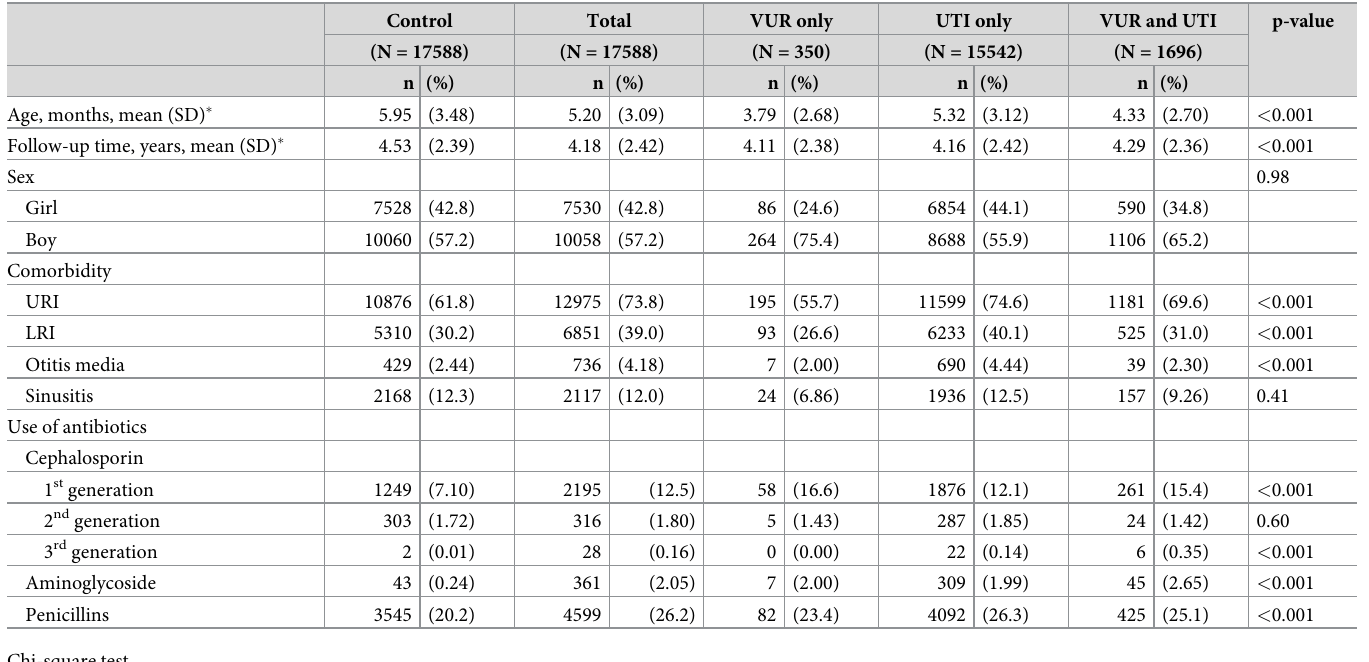
Table 1. Demographics among the 4 cohorts: Vesicoureteral reflux (VUR) cohort, urinary tract infection (UTI) cohort, VUR and UTI cohort, and control cohort.